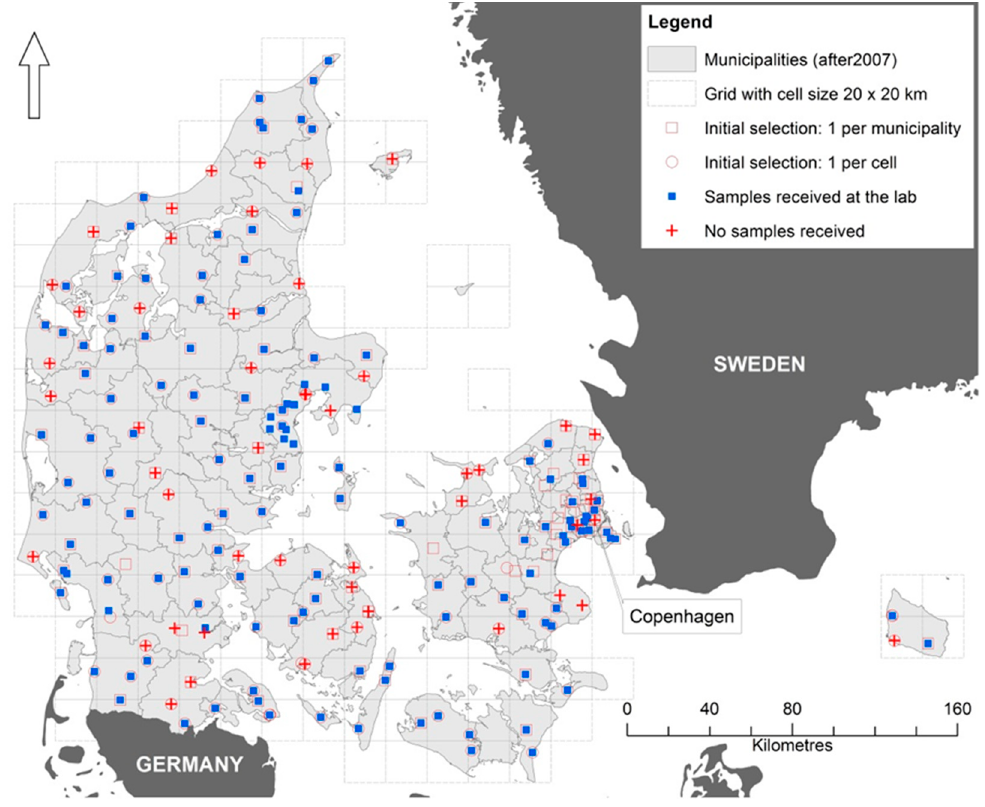
Figure 1. Sampling point location. Symbols: initial waterworks selection, based only on the two selection criteria ( n = 181): 1st selection criteria (red empty square), 2nd criteria (red empty circle); waterworks which sent samples to the lab ( n = 144) (blue square); contacted waterworks which did not participate i.e., no answer; negative answer; answered positively, but samples were not received at the lab (red cross) (note: the arrow indicates North direction).